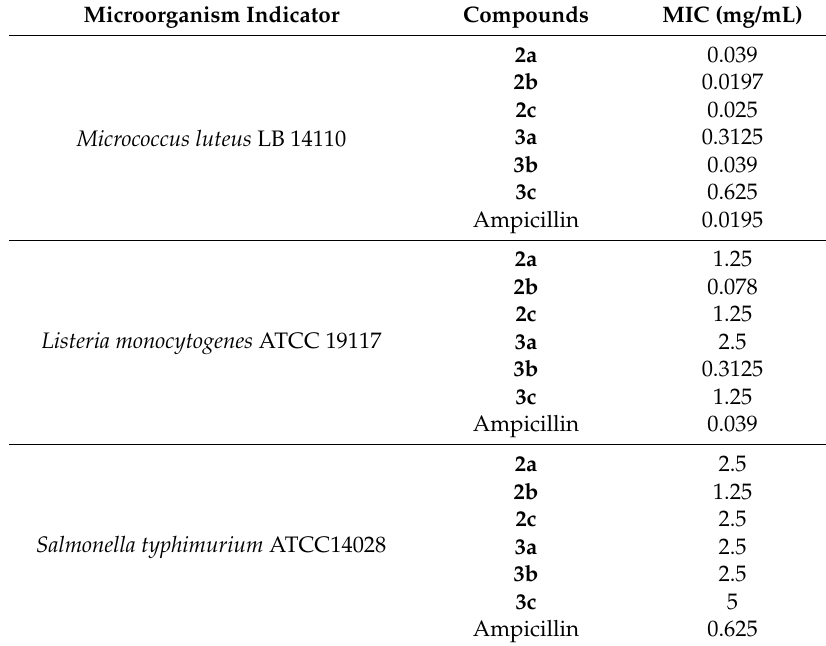
Table 5. Minimum Inhibitory Concentrations (MICs) expressed in mg/ml of compounds 2 – 3 . Microorganism